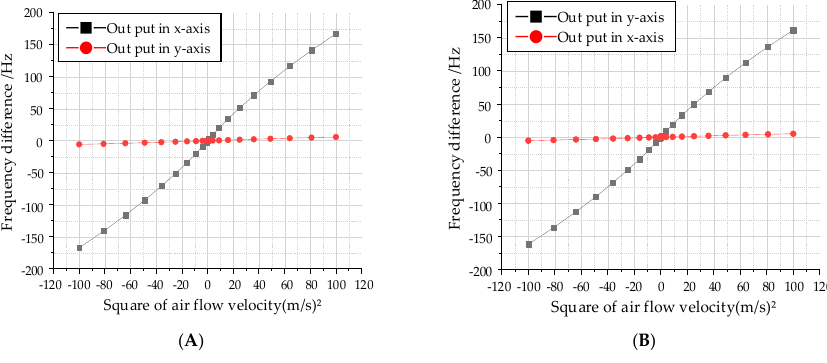
Figure 5. Influence of cross coupling on input and output characteristics. ( A ) The cross-coupling input air flow in the x-axis. ( B ) The cross-coupling input air flow in the y-axis.